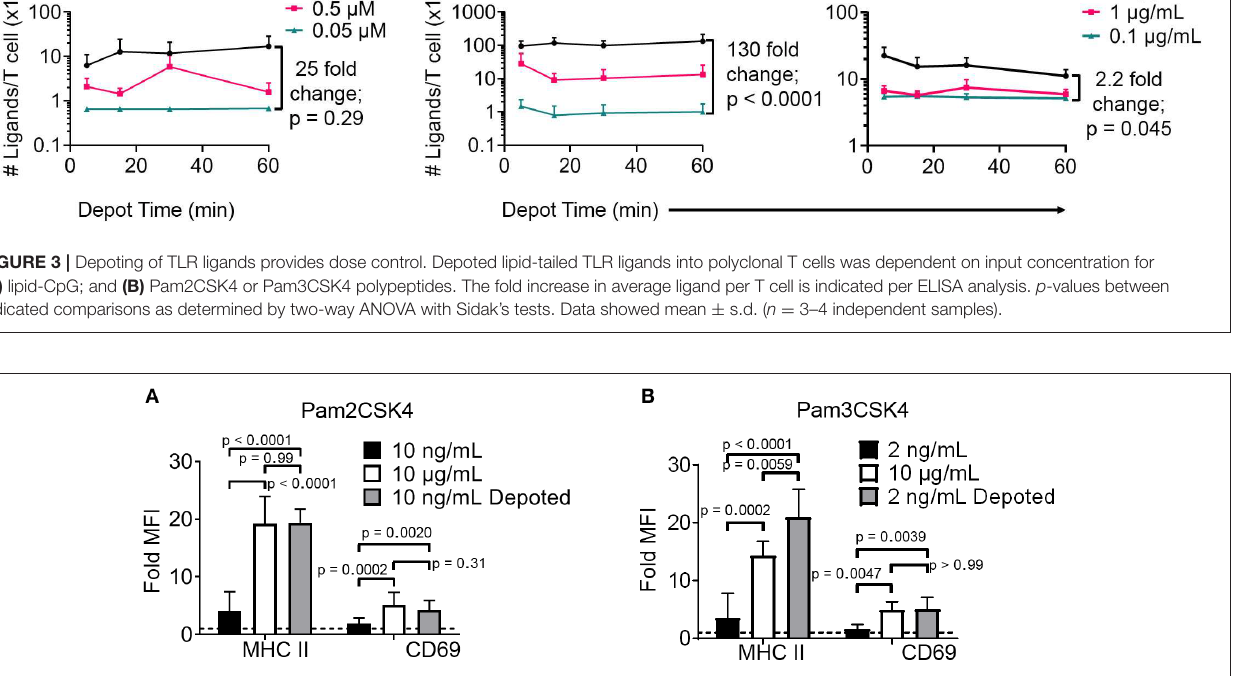
FIGURE 4 | Depoted TLR ligands activate cells through paracrine signaling. Polyclonal T cells were incubated with (A) Pam2CSK4 or (B) Pam3CSK4 for 1h under indicated conditions, and then co-cultured with B cells for 2 days. B-cell activation was determined by fold MFI of activation markers, MHC II and CD69, as measured by flow cytometry. Sample MFIs were normalized to unstimulated B cell controls. Dashed line represents theoretical no activation (MFI = 1). p -values between indicated conditions were determined by RM one-way ANOVA with Sidak’s method for multiple comparisons correction. Data showed m ± s.d. ( n = 5–6